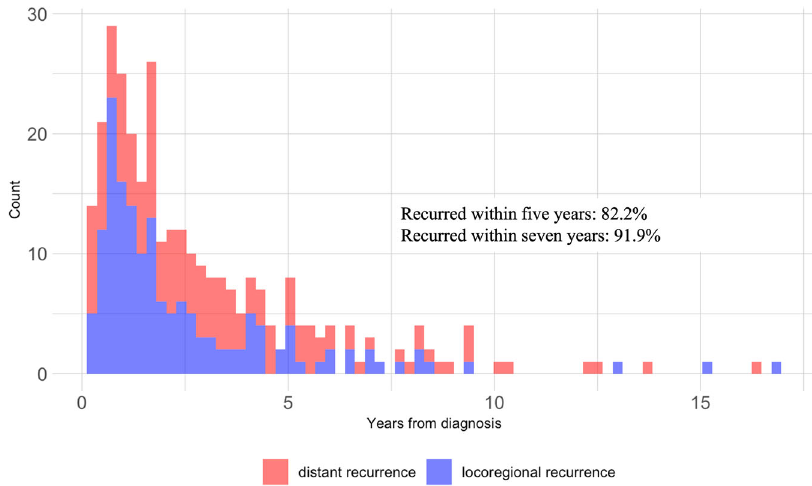
Fig. 2 Distribution of recurrent melanomas in the study population. Among the 310 recurrent melanomas, 255 (82%) recurred within fi ve years and 285 (92%) recurred within 7 years of primary melanoma